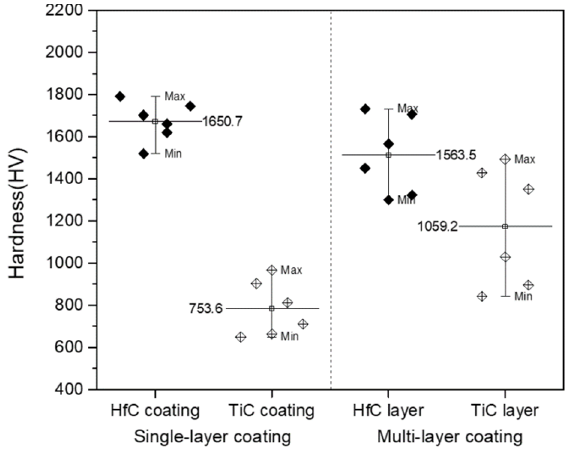
Figure 7. Vickers hardness of the HfC, TiC, and HfC/TiC coatings.